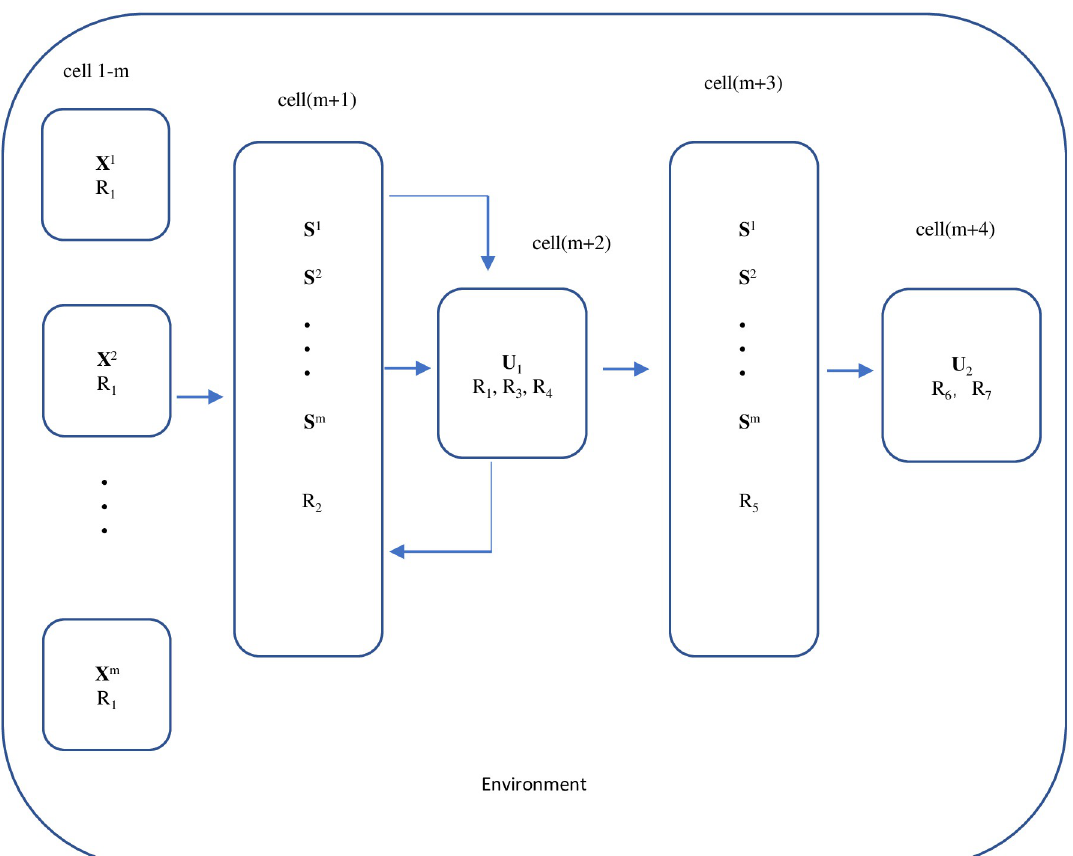
Fig 2. The RMVCP algorithm process in the framework of the tissue-like P system.